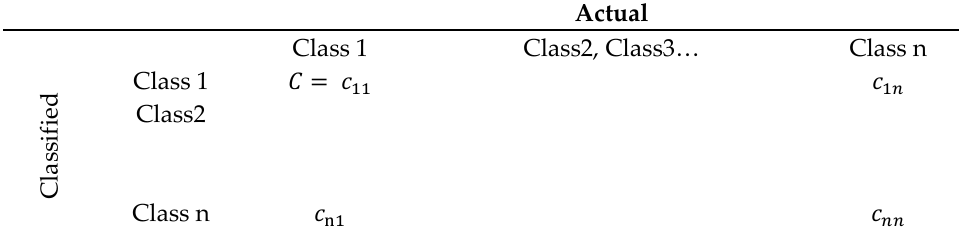
Figure 6. The multi-class confusion matrix.